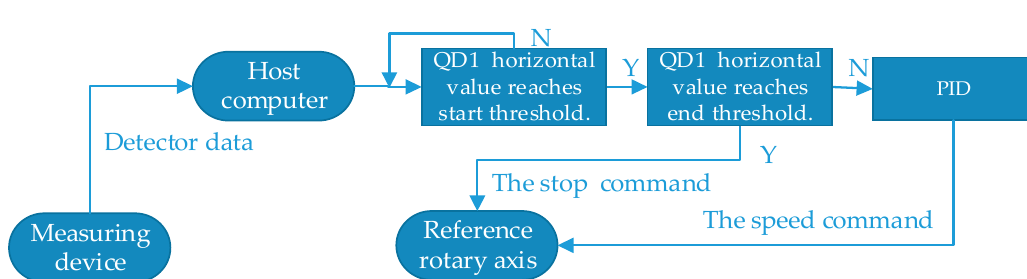
Figure 2. Schematic diagram of the tracking process.